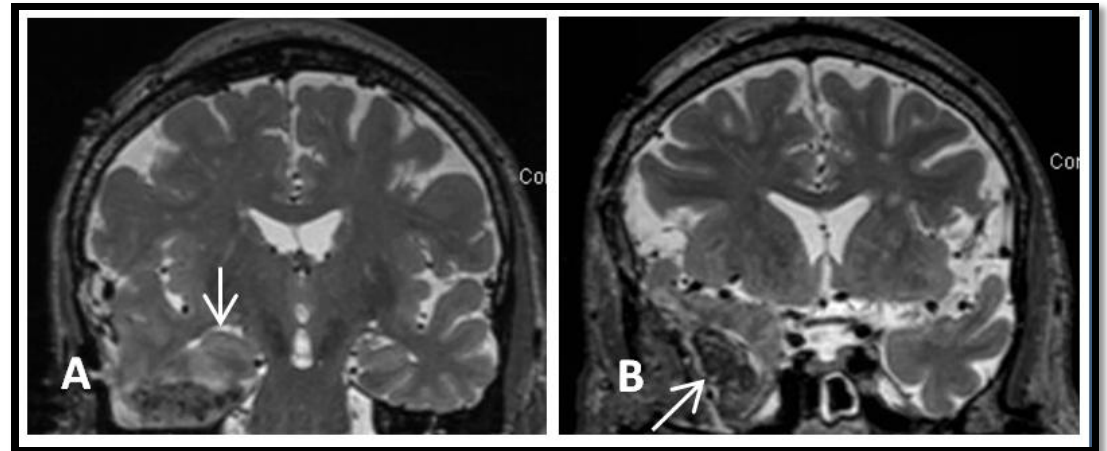
Figure 7. A post-operative brain MRI showing postsurgical changes related to resection of an encephalocele and the floor of the right middle cranial fossa. ( A ) Preserved right hippocampus (vertical arrow). ( B ) A surgical defect at the anterior aspect of the right temporal lobe (arrow).